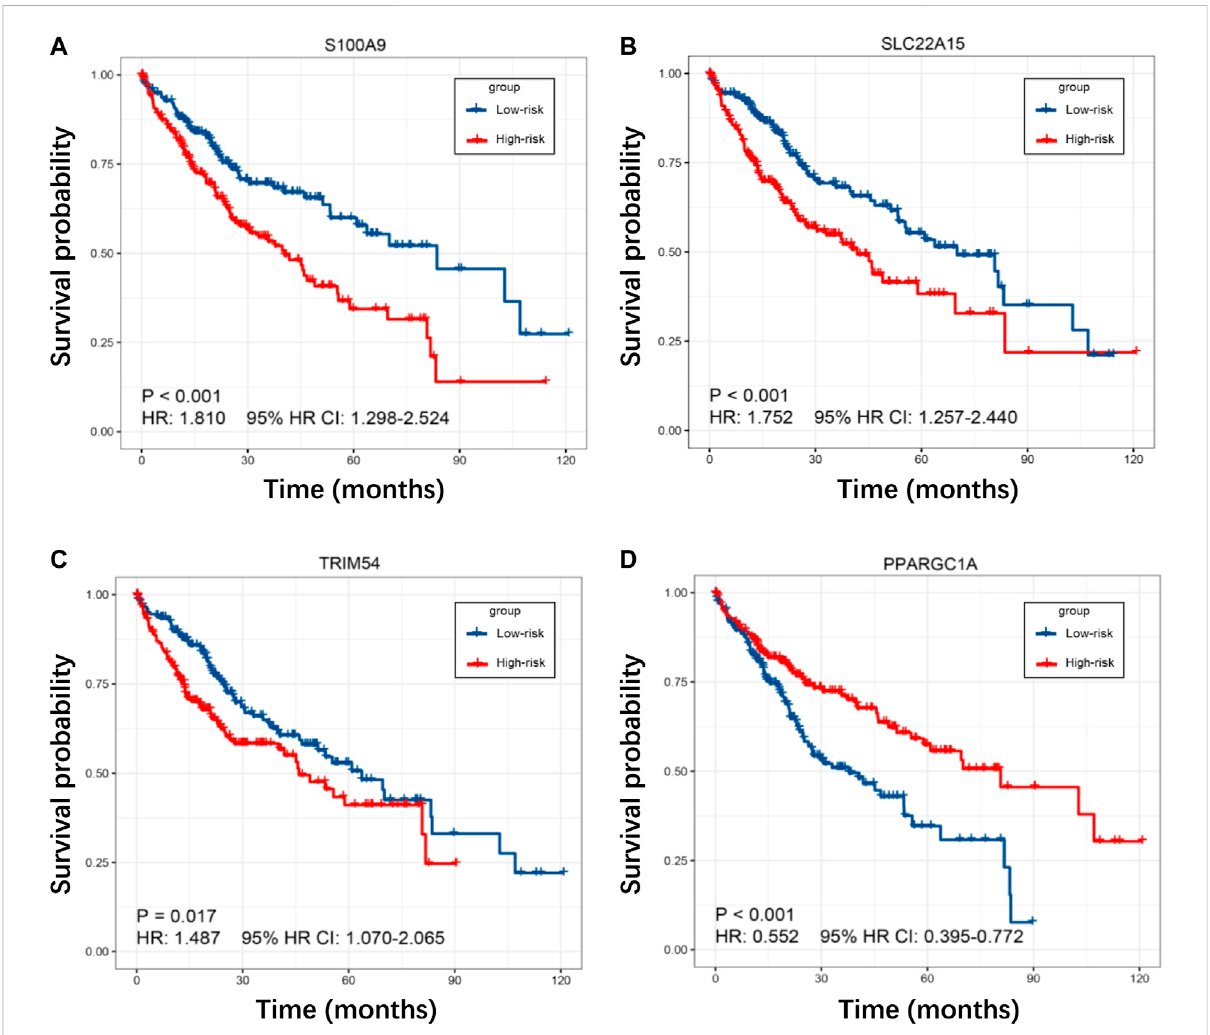
FIGURE 6 (A – D) K – M curves for S100A9, SLC22A15, TRIM54, and PPARGC1A in the TCGA